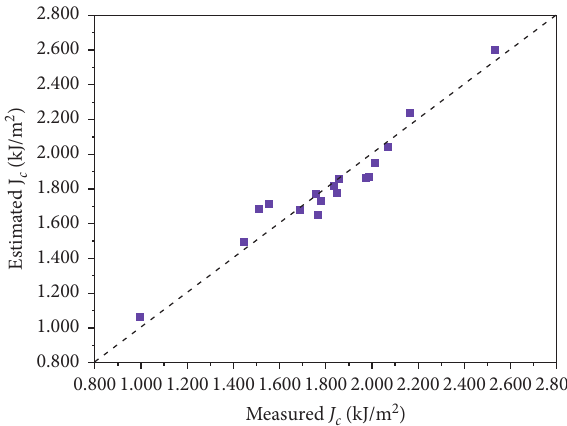
Figure 12: Comparisons of measured and estimated J